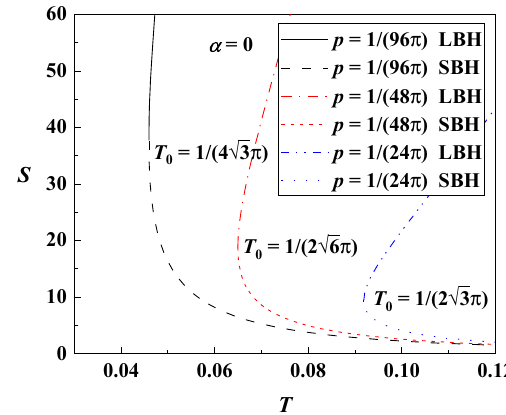
Fig. 3 The Gibbs free energies of large and small Schwarzschild–AdS black holes at arbitrary temperature and pressure. The G – T curves of the thermal AdS space and the stable large black holes intersect at the HPphasetransitiontemperature T HP ,whichincreasesatlargepressures. Below or above T HP , the thermal AdS or the large black hole phase is globally preferred. The G – T curves of the unstable small black holes are always above the T -axis, so the HP phase transition never